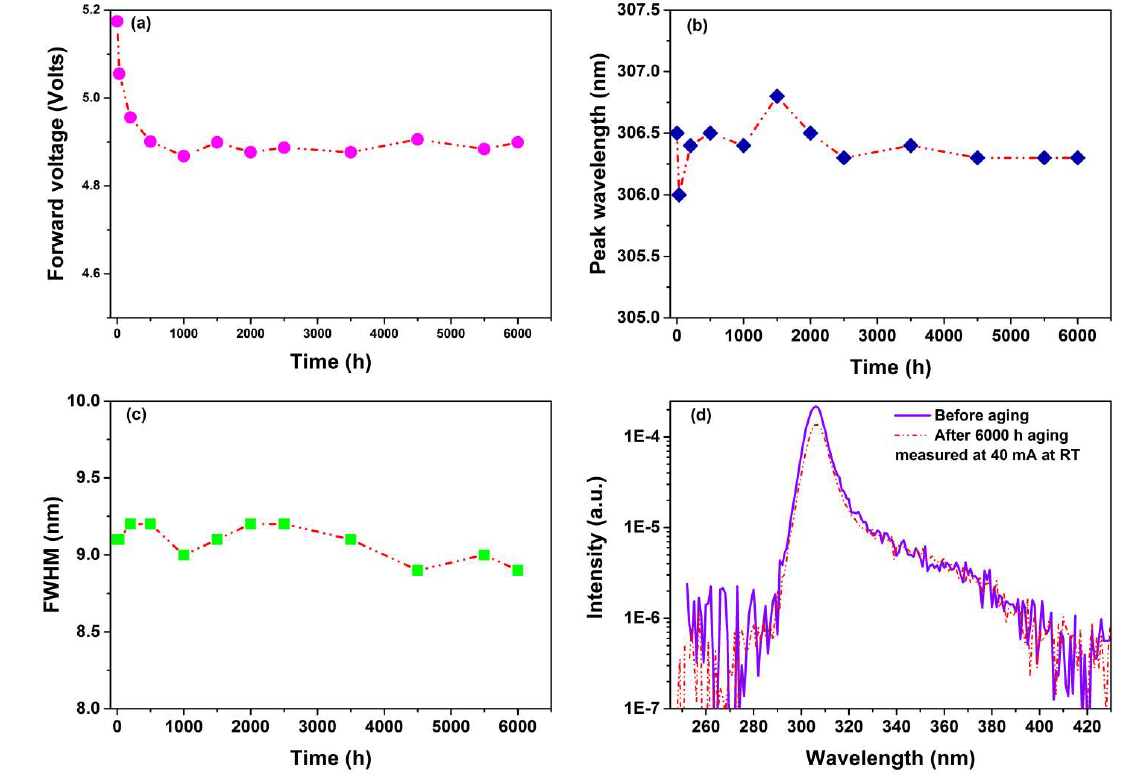
Figure 6. ( a ) Forward voltages, ( b ) EL peak wavelengths, and ( c ) EL FWHMs of the AlGaN-based UVB-LED measured at a value of I f of 40 mA during the aging tests. ( d ) EL emission spectra of the AlGaN-based UVB-LED measured at a value of I f of 40 mA before and after performing the aging tests.